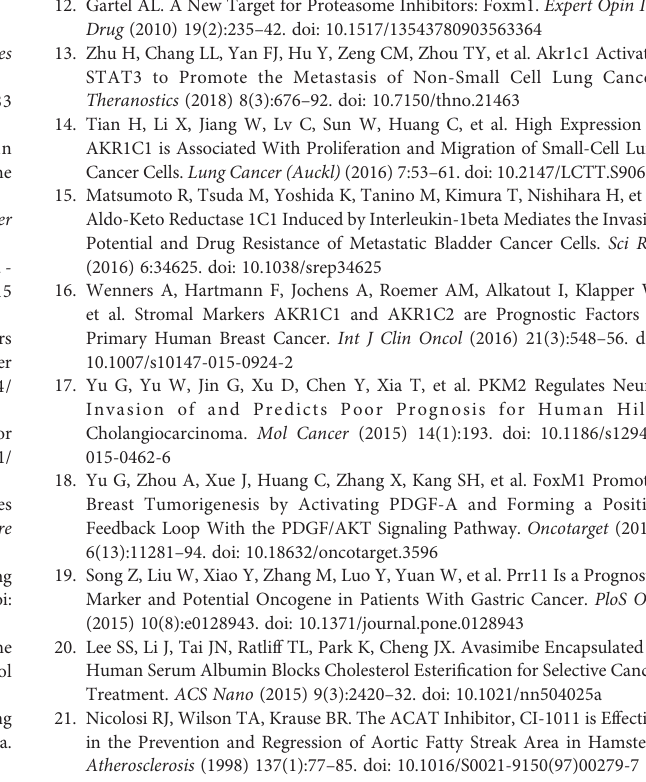
Supplementary Figure 1 | (A) RBE cells were treated with avasimibe for 24 and 48hours andsubjected tocDNAarray analysis. Intersection of genesbetween 24/0 and 48/0 hour. (B) Signi fi cant GO terms retrieved by clusters of genes involved in theunionofA. (D) Signi fi cantGOtermsretrievedbyclustersofgenesinvolvedinthe intersection of A. GO, gene